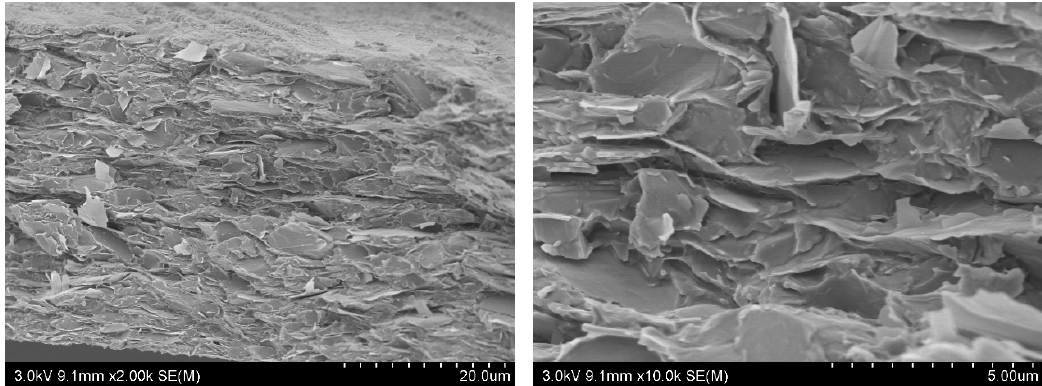
Figure 3. Cross-sectional morphology of SF / GrP / BD films (SF:GrP:BD = 10:2:1).